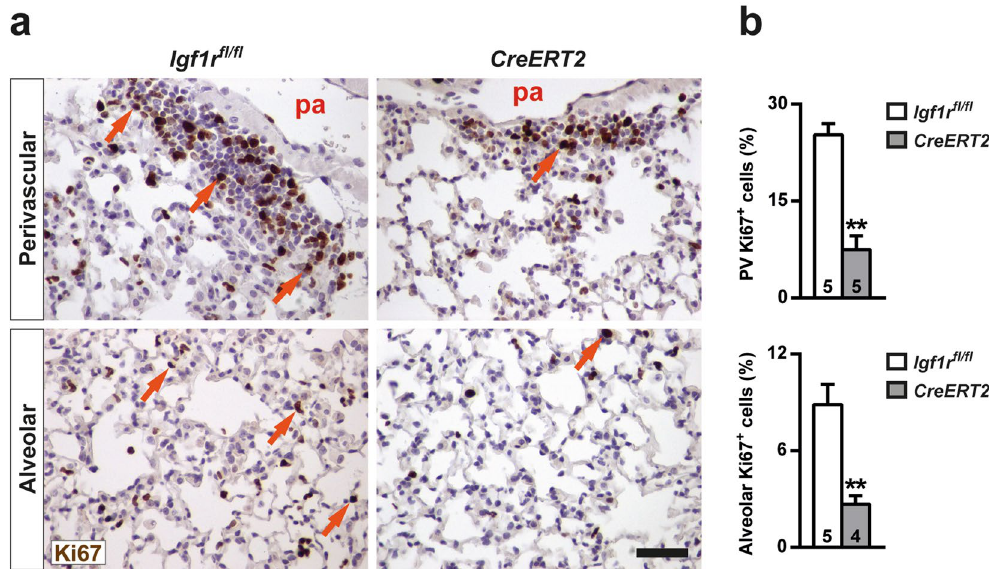
Figure 5. Diminished cell proliferation in IGF1R-deficient lungs after BLM challenge. ( a ) Representative images of Ki67 immuno-staining (in brown, orange arrows) under the pulmonary artery (top) and in the alveolar parenchyma (bottom), and ( b ) quantification of cell proliferation rates (Ki67 + ) in BLM treated UBC- CreERT2 ; Igf1r fl / fl ( CreERT2 ) vs . Igf1r fl / fl lungs at D3 (scale bar: 20 μ m). Numbers within graphic bars indicate the number of mice analyzed and data are expressed as mean ± SEM. ** p < 0.01 (Mann-Whitney U test). PV, perivascular; pa, pulmonary